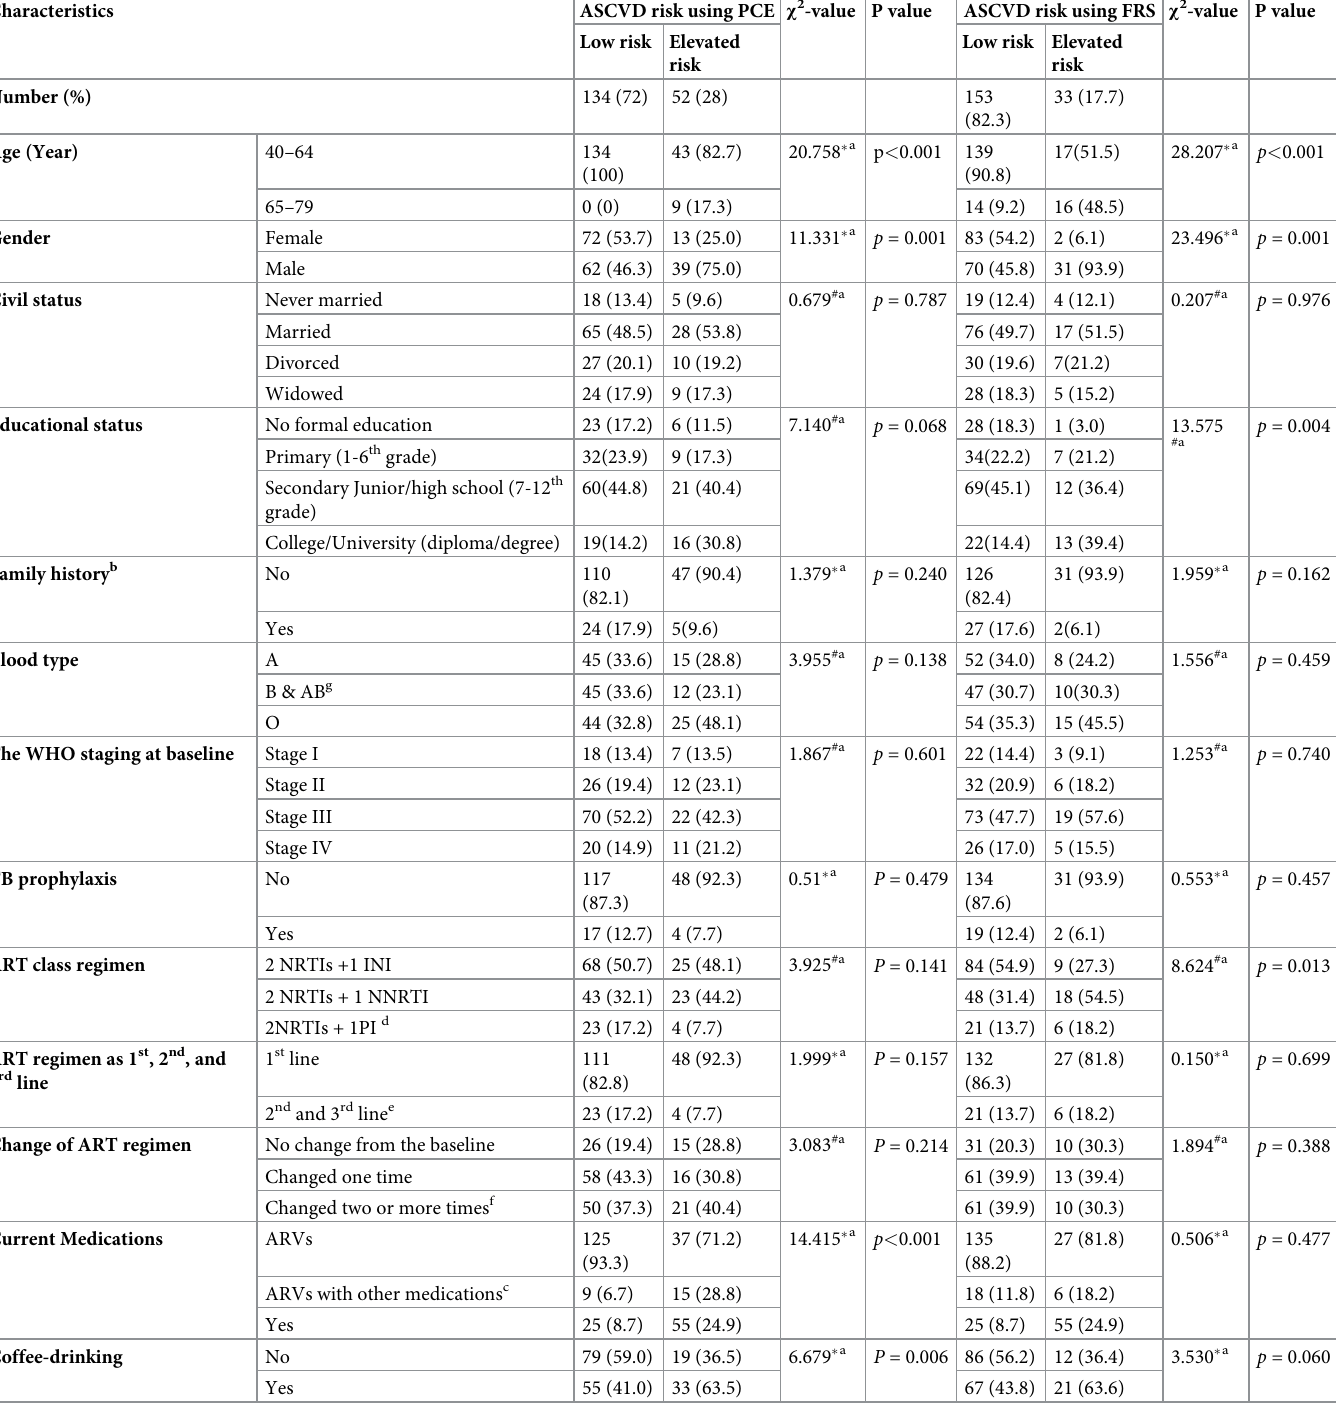
Table 2. The risk for atherosclerosis cardiovascular disease using the Pooled Cohort Equation and the Framingham Risk Score in HIV-infected patients aged 40 to 79 years at Zewditu Memorial Hospital, Addis Ababa, Ethiopia.